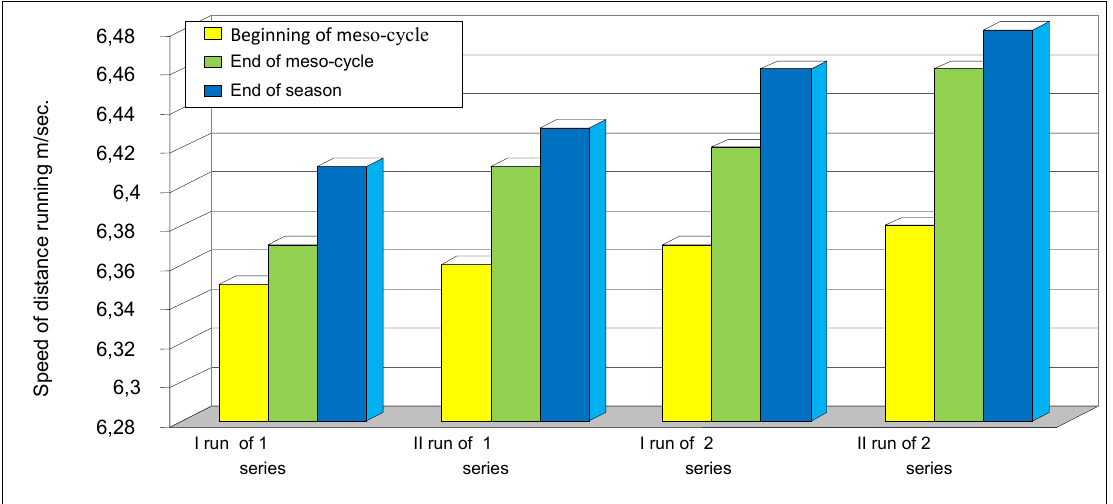
Fig.1. Dynamic of development of middle distance runners’ speed endurance